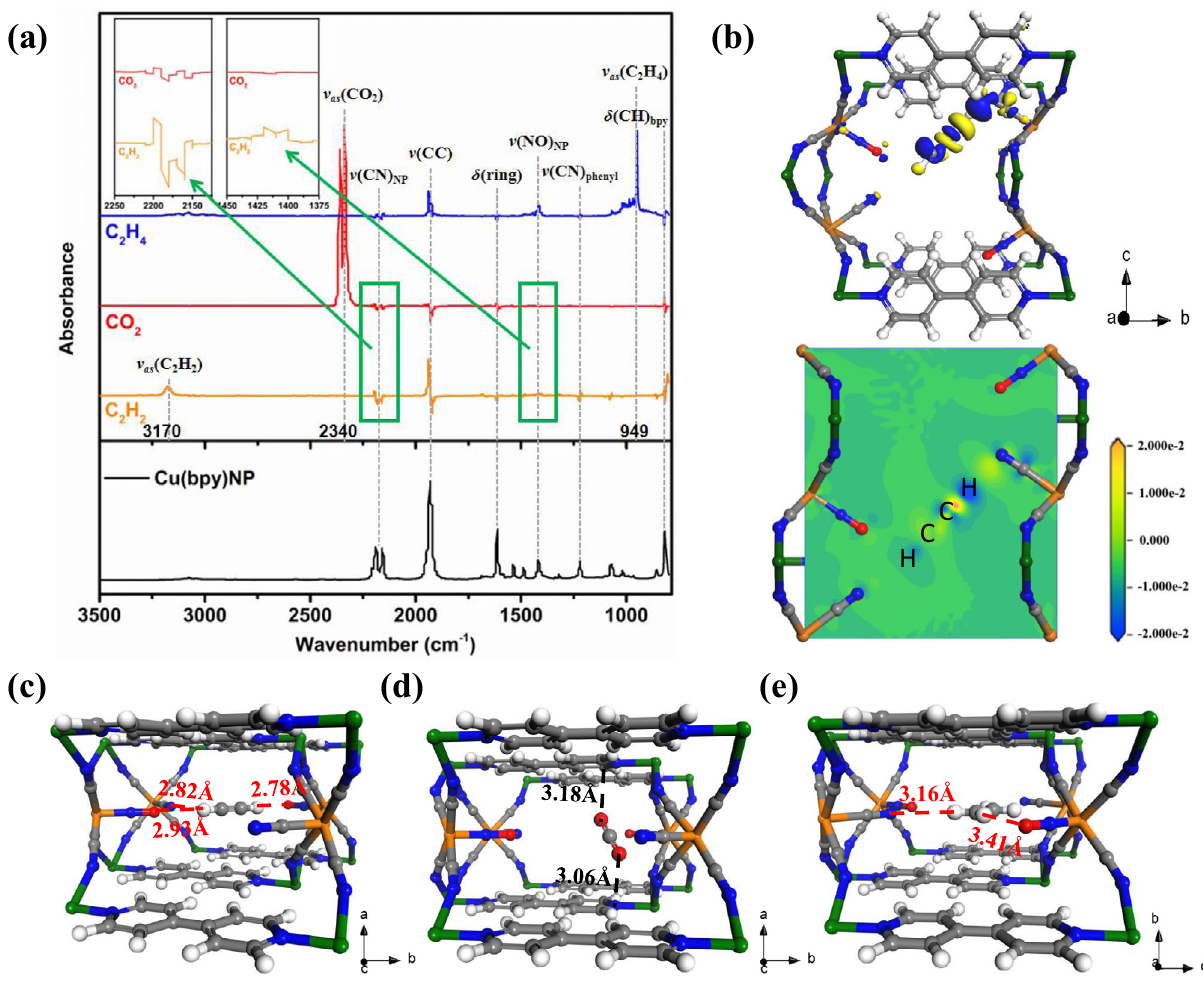
Fig. 4 | In-situ IR spectra and binding sites for C 2 H 2 , CO 2 , and C 2 H 4 in Cu(bpy) NP. a In-situ IR spectra of gas-loaded Cu(bpy)NP samples; b Charge density dif- ferenceplotsshowingtheinteractionbetweenC 2 H 2 ;DFT-Dcalculatedbindingsites